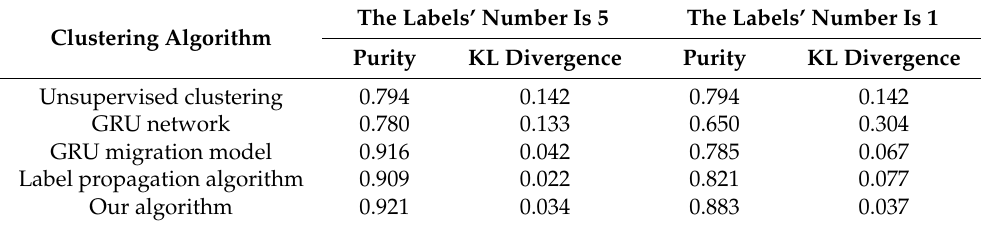
Table 3. Experimental results of different algorithms under the condition of few